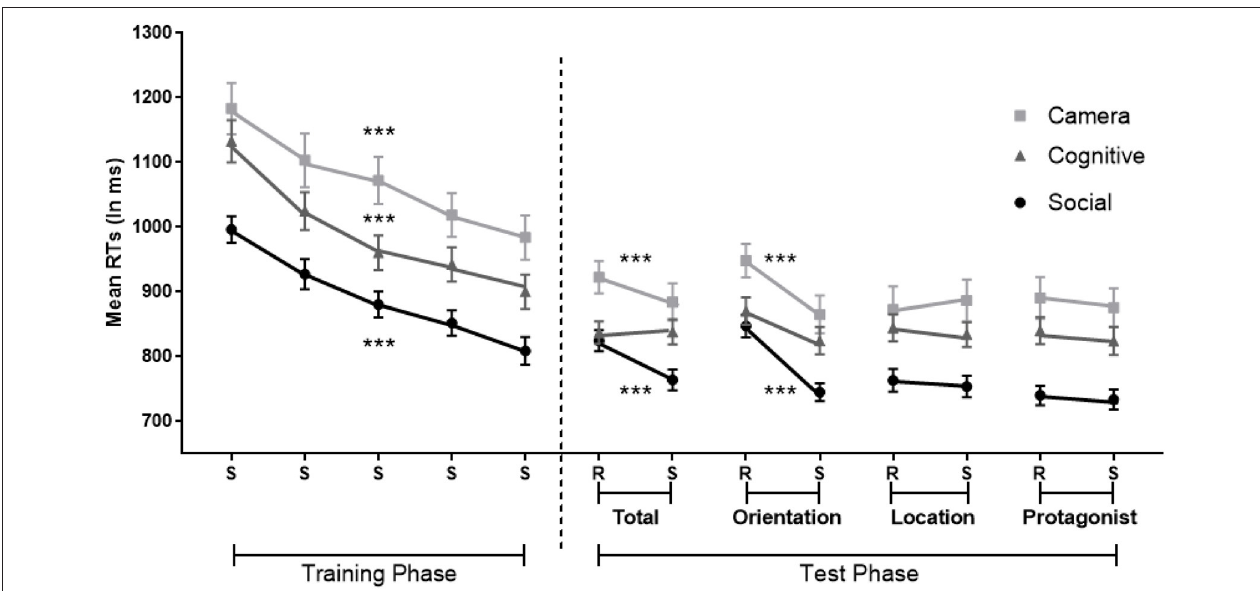
FIGURE 6 | Implicit sequence learning in the Social, Camera and Cognitive Conditions in which the sequence is standard (S) or random (R), with randomization involving orientation (Orientation), the flower’s location (Location); the protagonists identity (Protagonist); or these three dimensions together (Total). Orientation involves true-false belief orientation in the Social Condition; current-outdated photos in the Camera Condition and green/blue vs. red/black colors in the Cognitive Condition. Protagonists are Papa Smurf and Smurfette in the Social Condition, gray and yellow cameras in the Camera Condition, and square and circle in the Cognitive Condition. Error bars = Standard errors of the mean. Random blocks of the same dimension and its adjacent sequence blocks were collapsed in the analysis. *** p < 0.001 for significant effects of general and specific implicit learning per condition.